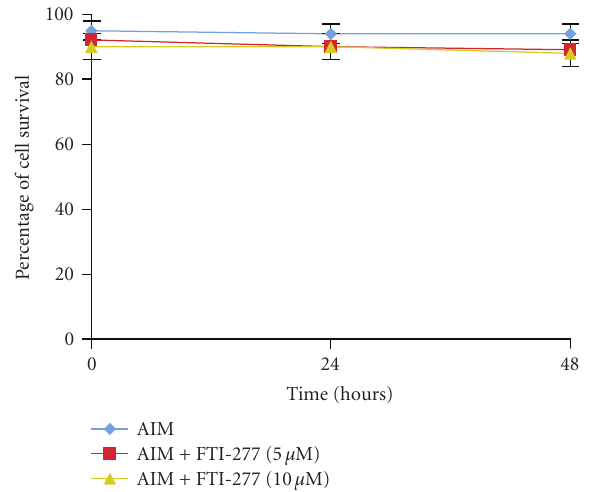
Figure 3: E ff ect of FTI-277 on survival of adipogenic di ff erentiating MSCs: MSCs were plated 96-well plates and induced to di ff erentiate into adipocytes. Cells were treated with either FTI-277 (5–10 μ M) or vehicle alone. After 24 and 48 hours, cell survival was assessed by MTS Formazan as described in methods. There was no di ff erence between treated and nontreated cells at both time intervals. This experiment was repeated three